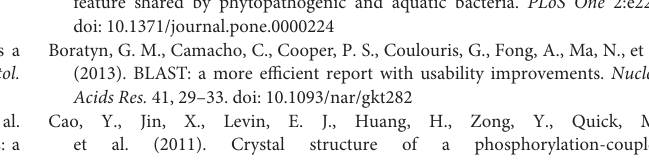
Supplementary Table 1 | Known enzymatic activity of glycoside hydrolase (GH) families in the selected clones based on the CAZy database and the substrates selected (based on activities in bold) for growth